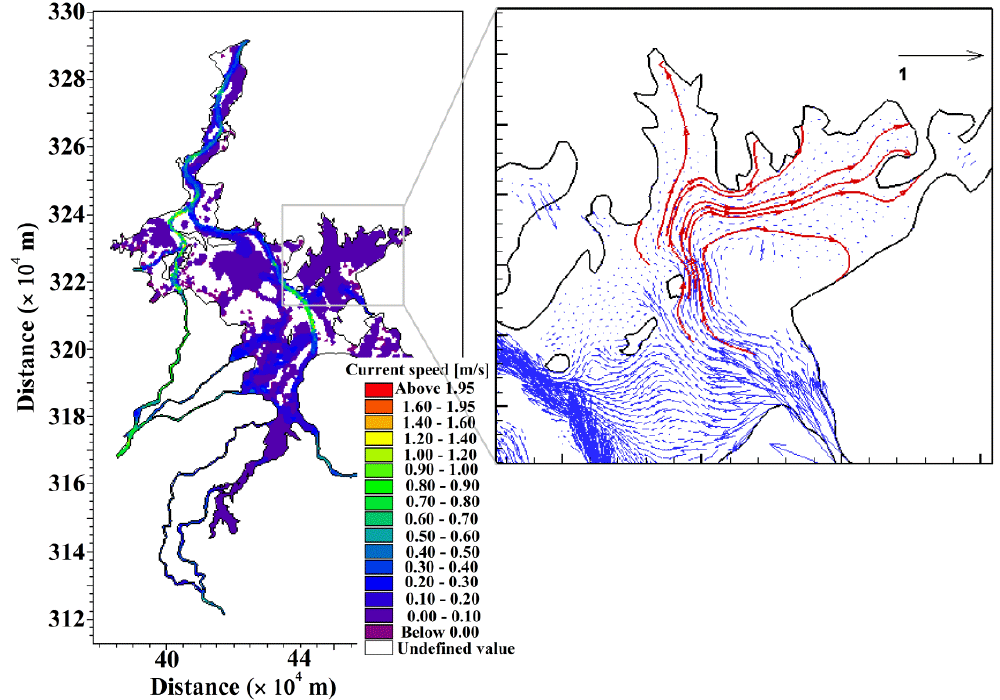
Figure 6. Map of the depth-averaged velocity (m/s) averaged over the water level rising period of MIKE 21 runs and a close-up of the velocity field for the region of interest. Red arrows represent the streamlines and associated flow directions. Note that the “Undefined Value” represents dry